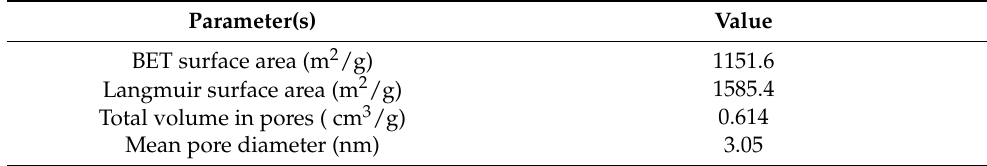
Table 3. Surface properties of